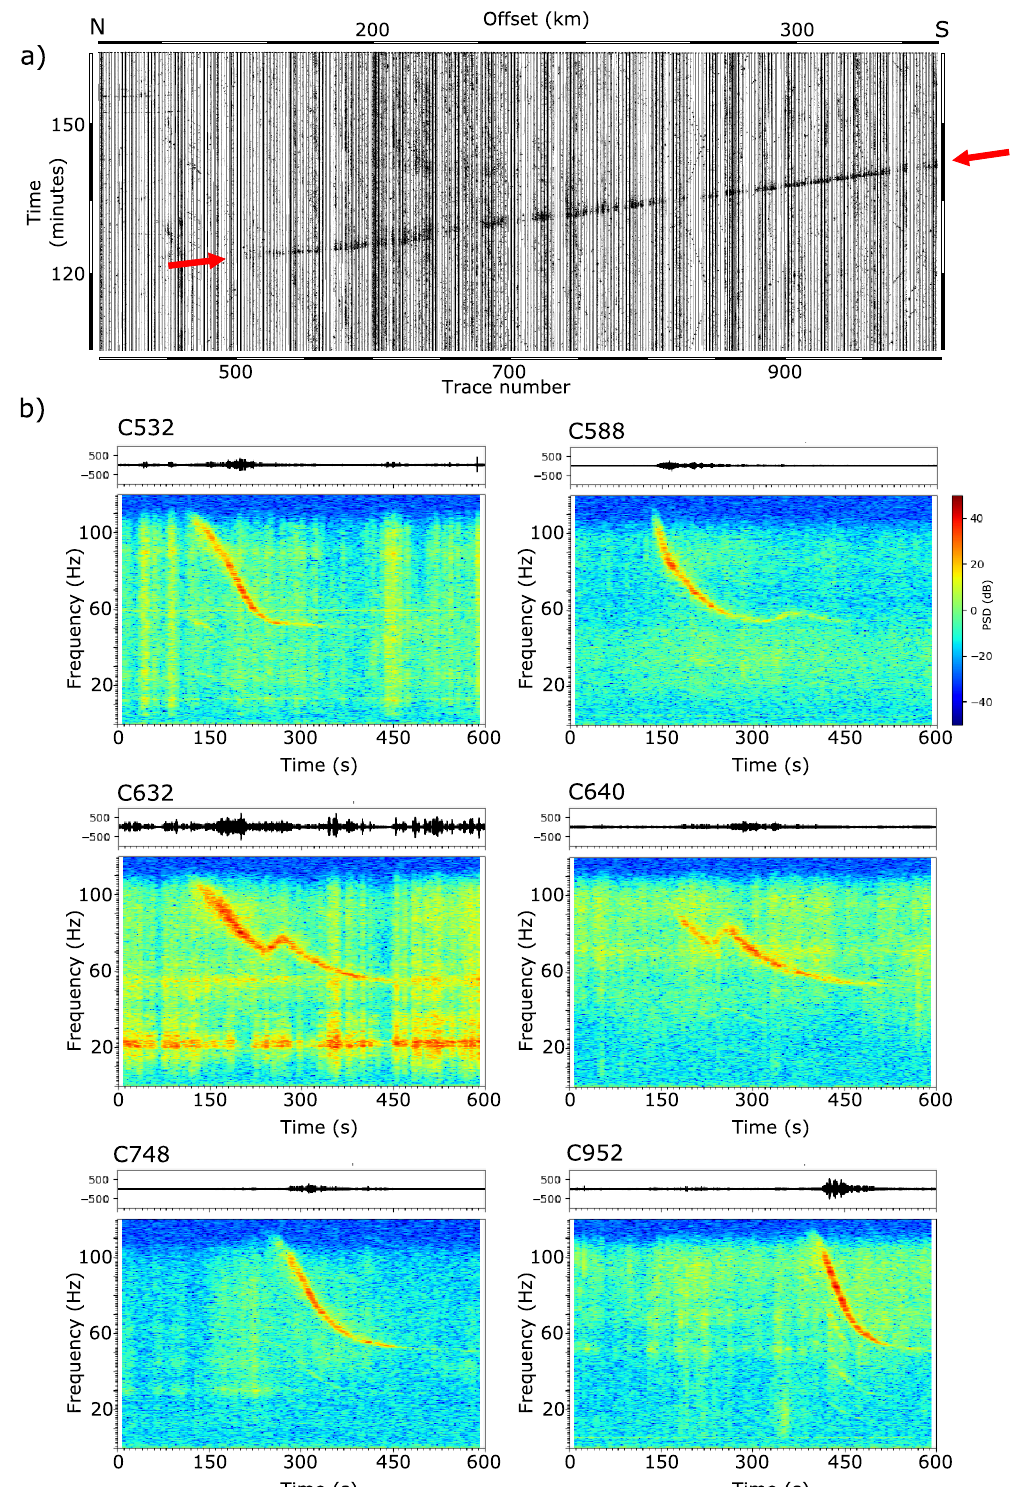
Figure 4. ( a ) Record section showing the arrival of the signals generated by an airplane overflying the profile (red arrows). ( b ) Raw signals and spectrograms for selected stations recording the overflight of the airplane. Variations in the shape of the spectrograms are interpreted as resulting from changes in the airplane trajectory (see